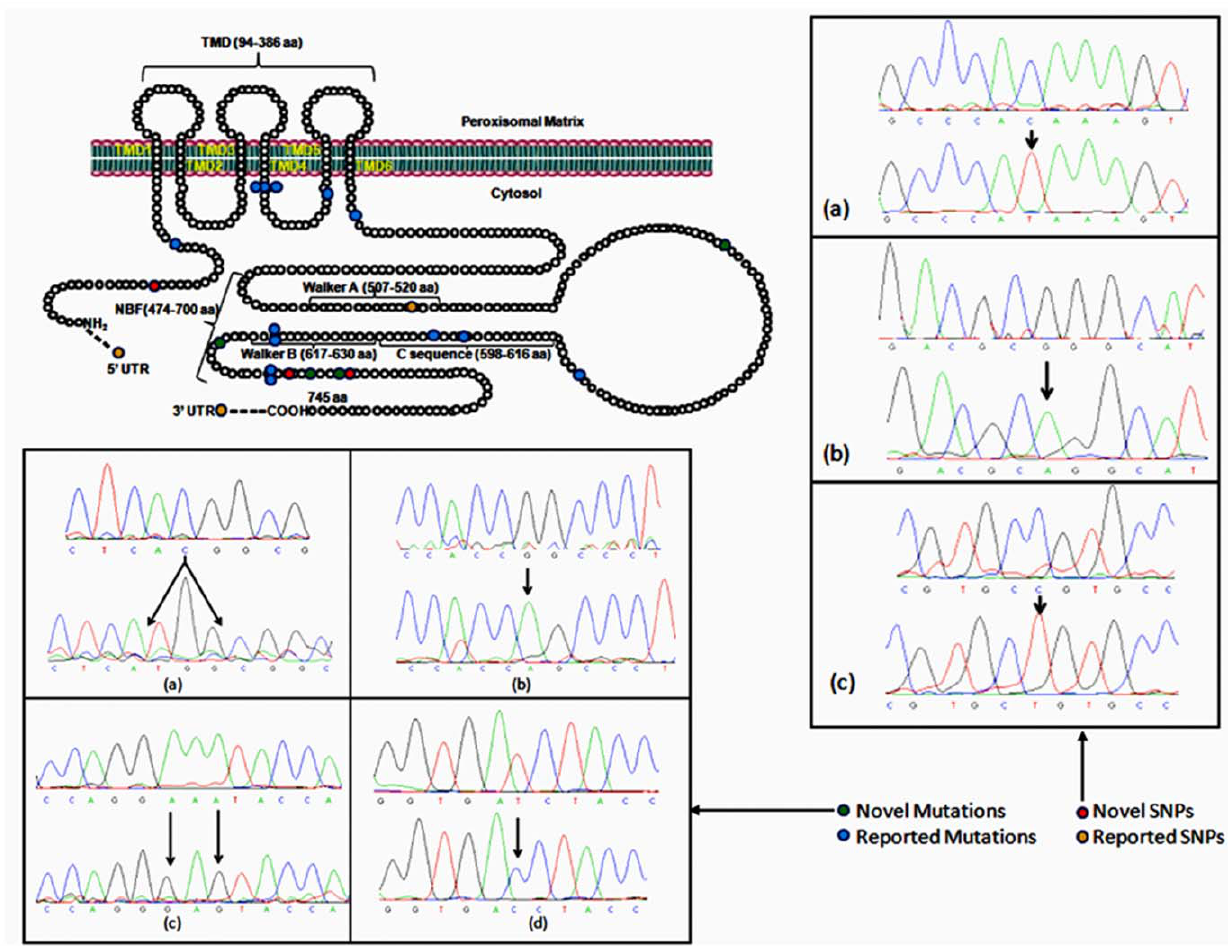
Figure 1. Mutations and SNPs identified in the ABCD1 gene. The upper left panel depicts all the mutations and SNPs that are localized in the schematic molecular structure of ALDP in the present study. The lower left panel shows the four novel mutations (a)